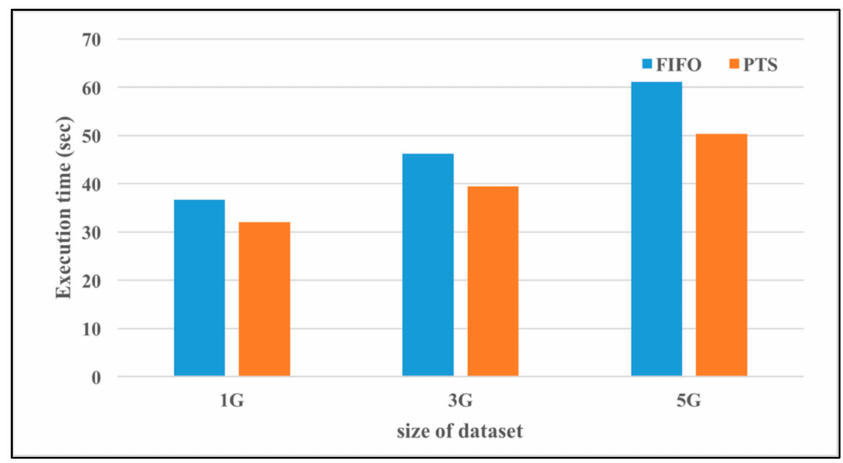
Figure 16. Execution time of executing WordCount by FIFO and PTS